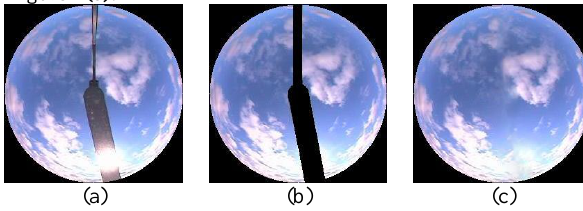
Figure 2. Image completion: (a) original image; (b) mask of shadow band; (c) restored